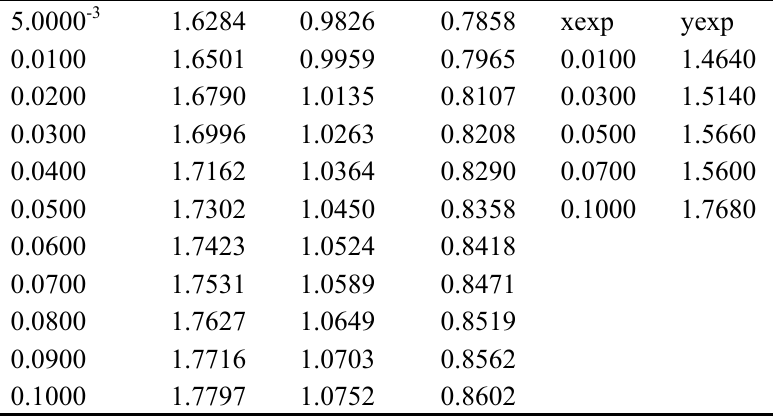
Table 4. Numbers used for plotting Figure 8 for experimental results vs. single electrode . e.m.f.s, with  AgCl